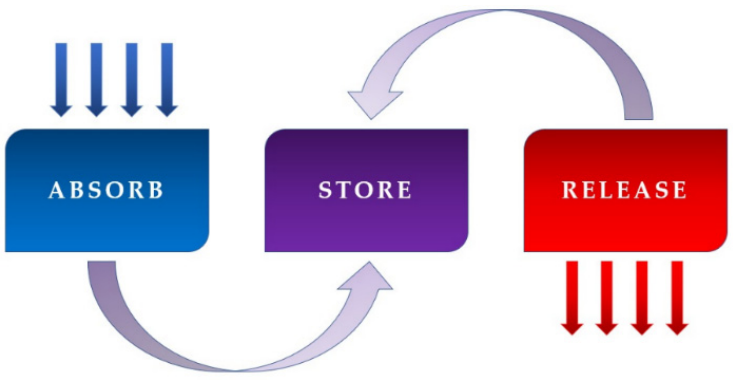
Figure 9. The PCMs working principle: absorbing the thermal energy, storing it during phase change (solid to liquid), and releasing the absorbed heat.